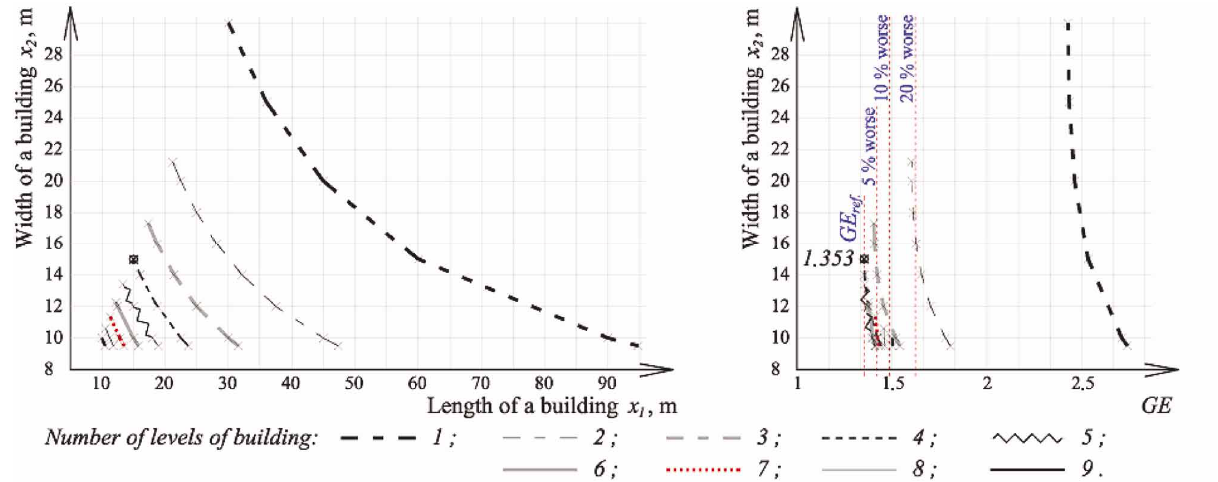
Fig. 5. Graph of the relationship between dimensions x 1 and x 2 of a building with an area of 900 m 2 and the number of storeys ranging from 1 to 9 (storey height h = 3.2 m), and graph of the corresponding GE values